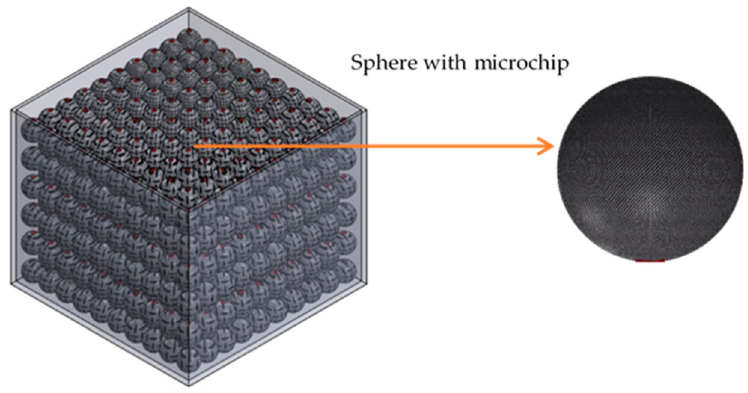
Figure 1. New system for hydrogen storage.